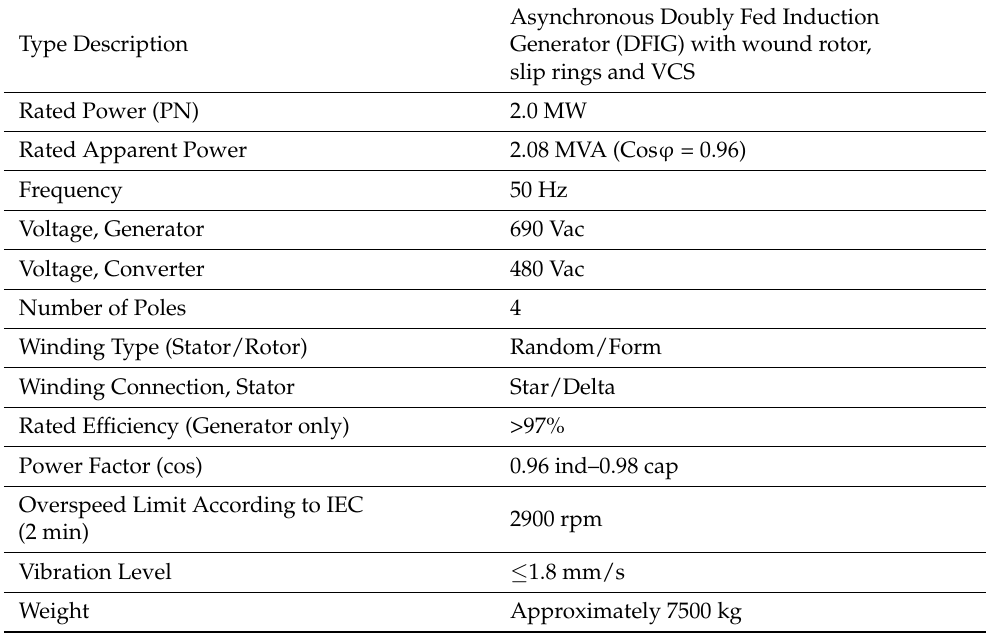
Table 2. Generator data.